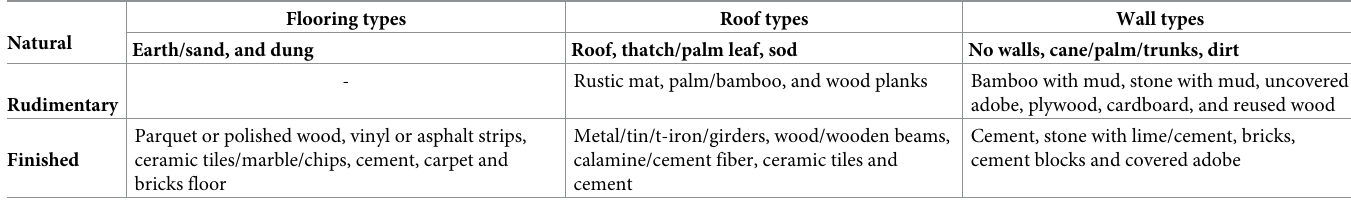
Table 1. Housing characteristic summary, MICS 2017–2018.